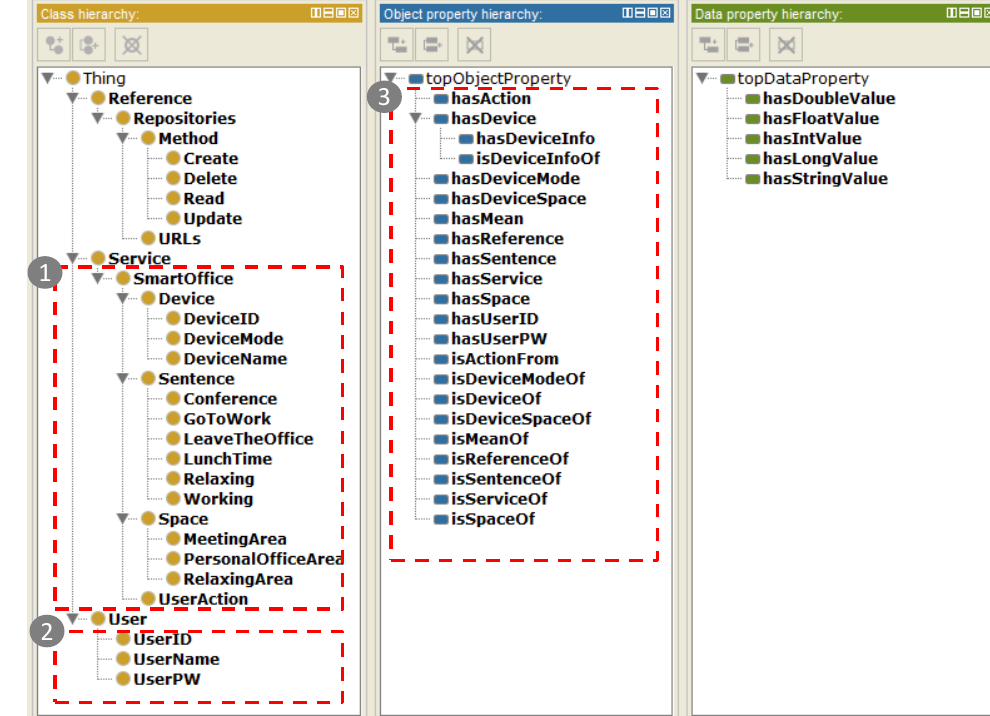
Figure 12. Result of the ontology added in the IIO with respect to the hierarchy of classes, object properties, and data